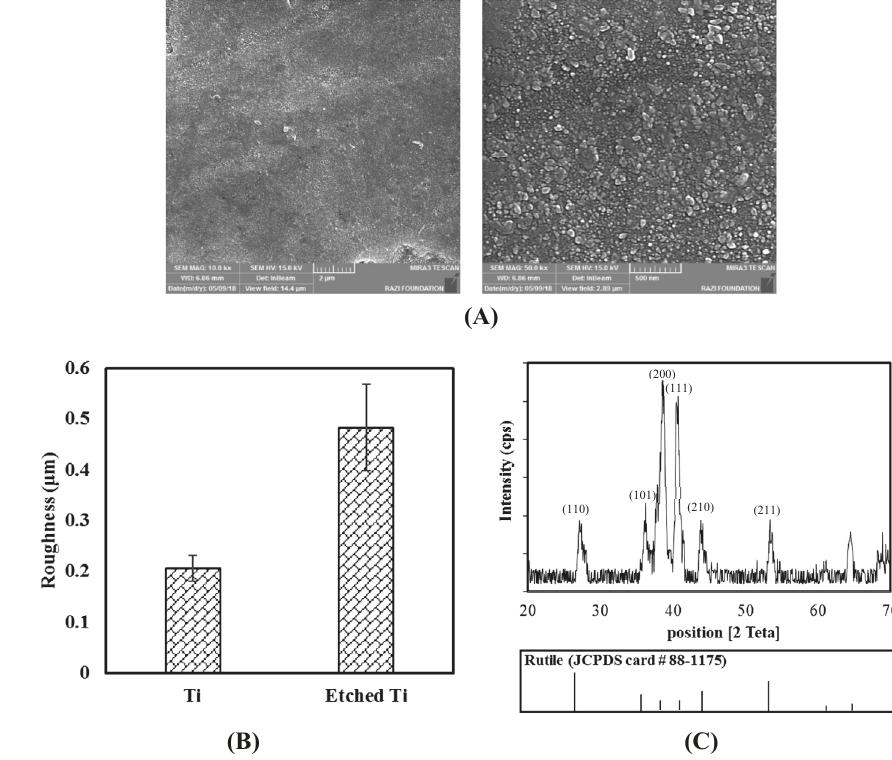
Fig. 1 A FE-SEM images of biomedical grade Titanium sheets after hydrothermal etching at 10 kx and 50 kx magni fi cation. B Surface roughness changes. C GIXRD pattern of hydrothermally etched